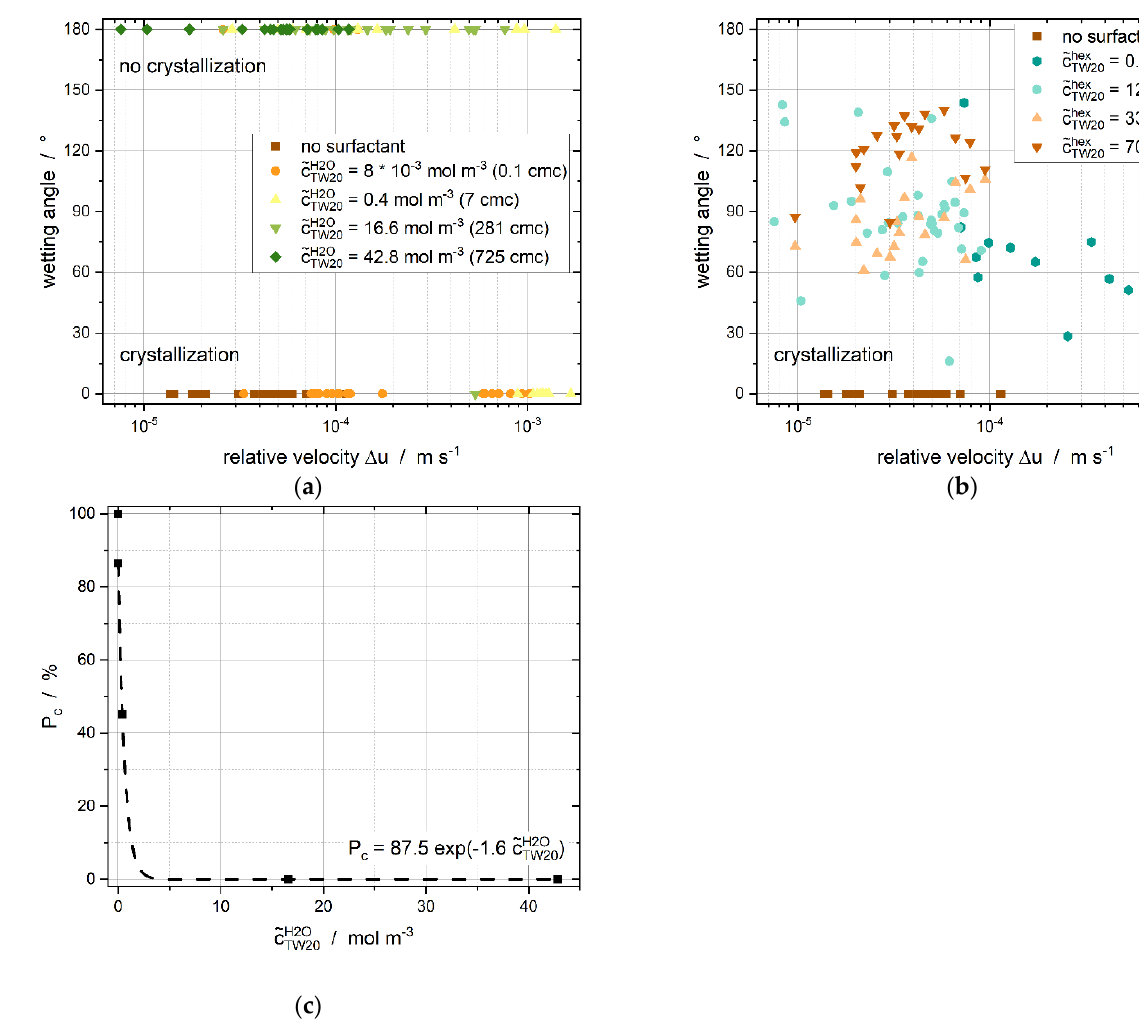
Figure 10. ( a ) Wetting angle as a function of the relative velocity (difference of velocities between droplets and particles) for different surfactant concentrations. Tween ® 20 was added to the continuous phase. ( b ) Wetting angle as a function of relative velocities for different surfactant concentrations as Tween ® 20 was dissolved in the dispersed phase. All experiments led to crystallization, but differences in the contact form were found according to the surfactant concentration. ( c ) Crystallization probability P c as Tween ® 20 was added to the continuous phase for relative velocities ranging from 10 − 5 up to 2 × 10 − 3 m s − 1